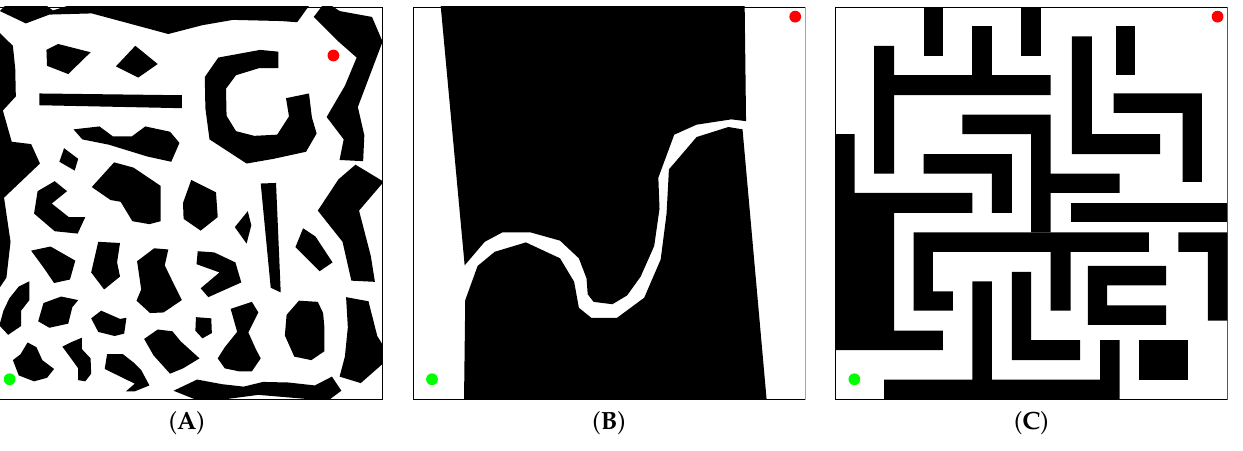
Figure 2. Workspaces used in test cases ( A – C ), respectively. Table 1. Details of the workspaces used in test cases (A), (B) and (C),